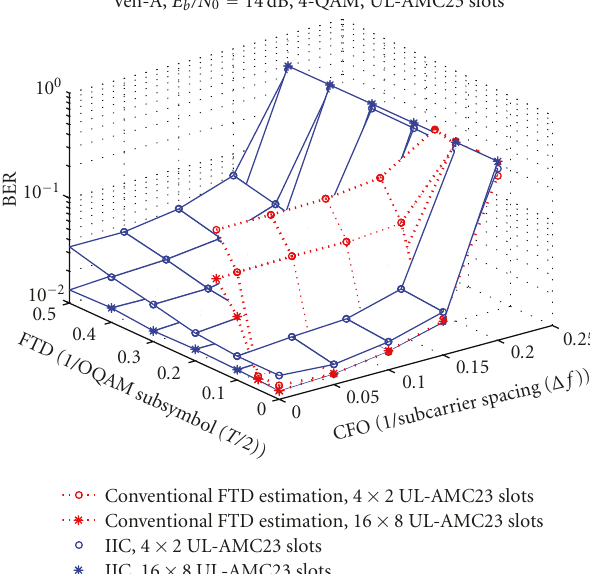
Figure 12: BER performance versus CFO and FTD of the IIC joint FTD and channel estimation method compared to classical FTD estimation. 4-QAM transmission of 4 × 2 and 16 × 8 AMC23 slots in Vehicular-A channel at E b /N 0 = 14 dB. Static user. No additional synchronization